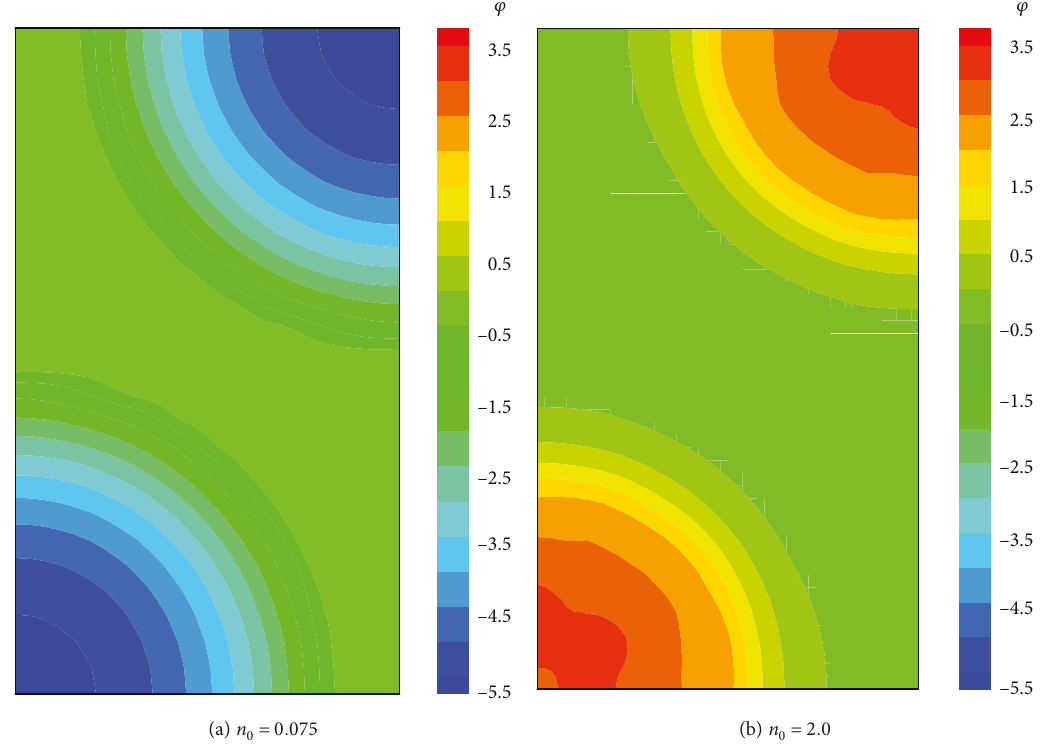
Figure 12: Potential distribution of the downstream surface of the decelerator grid of the 3-grid